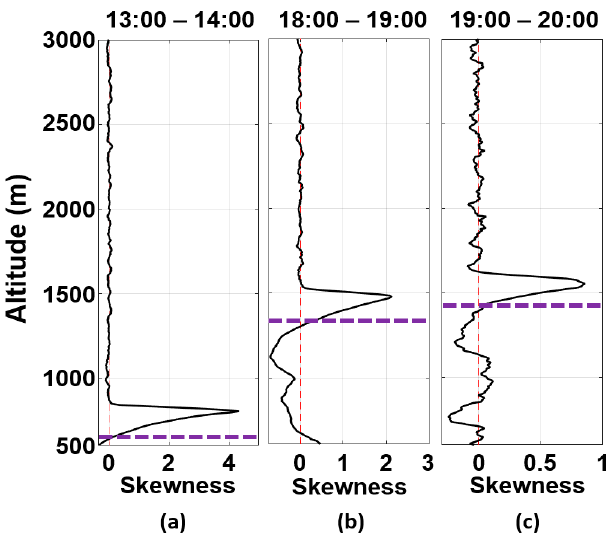
Figure 11. RCS 532 skewness profiles obtained on 23 July 2019, between ( a ) 13:00–14:00 UTC, ( b ) 18:00–19:00 UTC, ( c ) 19:00–20:00 UTC. The purple dotted line represents the CBLH. Sensors 2020 , 20 , x FOR PEER REVIEW